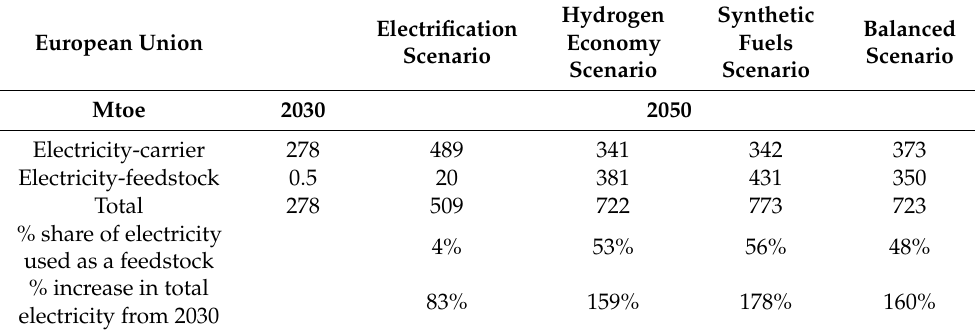
Table 7. Electricity utilization